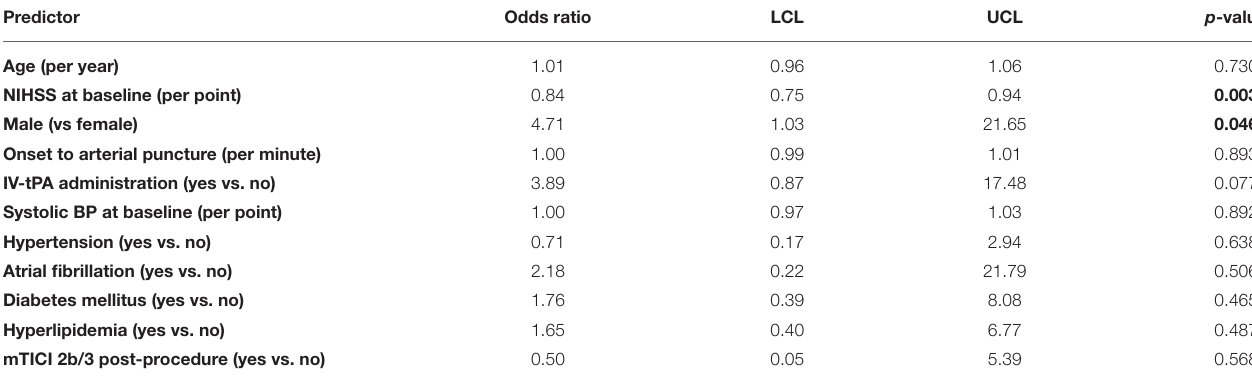
TABLE 5 | Predictors of good functional outcome (mRS 0–2) in patients with posterior circulation ischemic stroke (univariate analysis). Predictor Odds ratio LCL